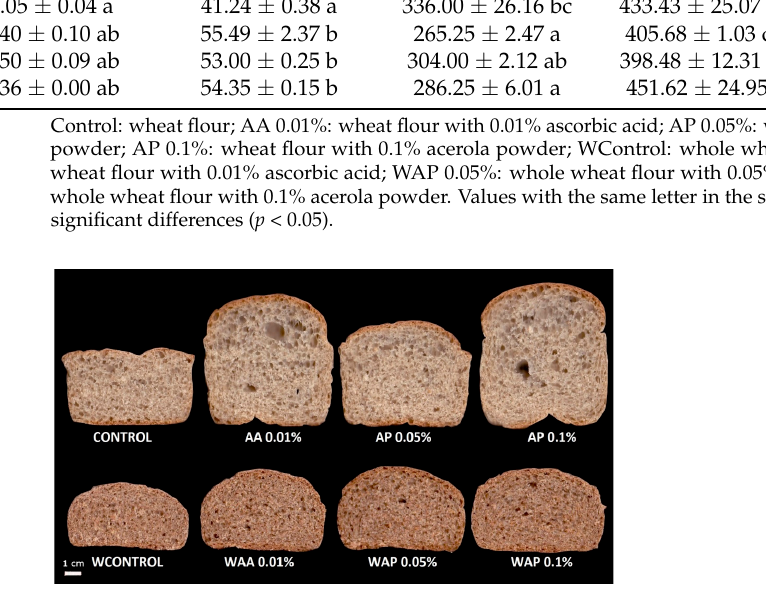
Figure 1. Bread slices scanner images elaborated with: Control: wheat flour; AA 0.01%: wheat flour with 0.01% ascorbic acid; WF AP 0.05%: wheat flour with 0.05% acerola powder; AP 0.1%: wheat flour with 0.1% acerola powder; WControl: whole wheat flour; WAA 0.01%: whole wheat flour with 0.01% ascorbic acid; WAP 0.05%: whole wheat flour with 0.05% acerola powder; WAP 0.1%: whole wheat flour with 0.1% acerola powder.